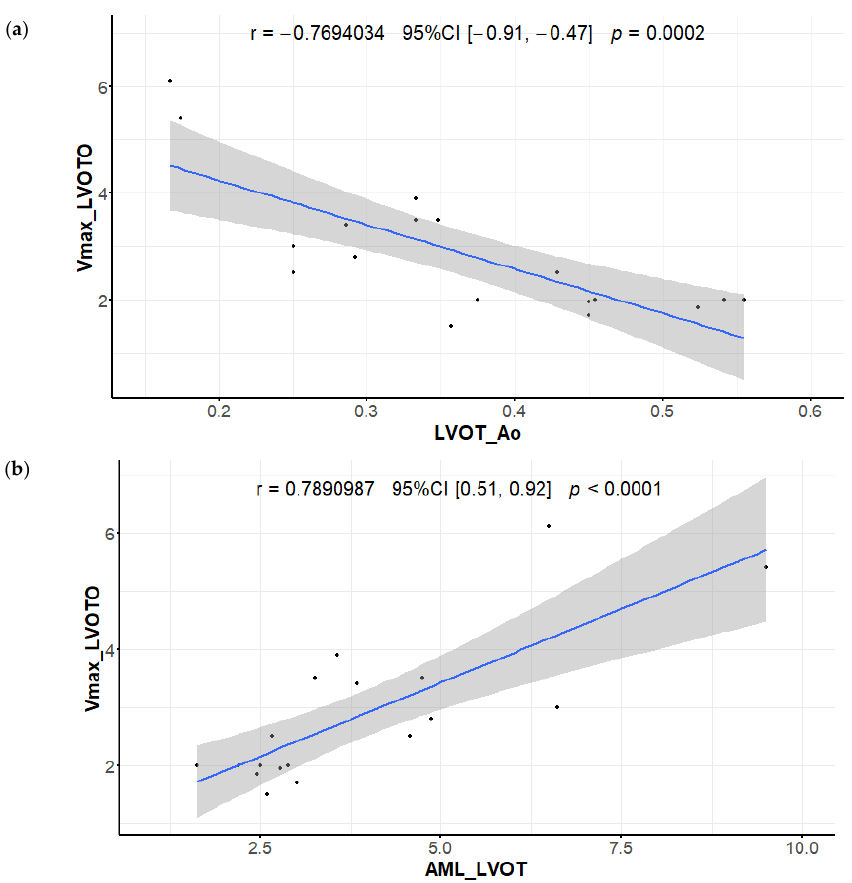
Figure 8. Correlation between maximal velocities measured in left ventricular outflow tract (m/s) and ( a ) the LVOT/Ao (left ventricular outflow tract diameter/aortic valve diameter) ratio; ( b ) the AML/LVOT (anterior mitral leaflet length/left ventricular outflow tract diameter) ratio.